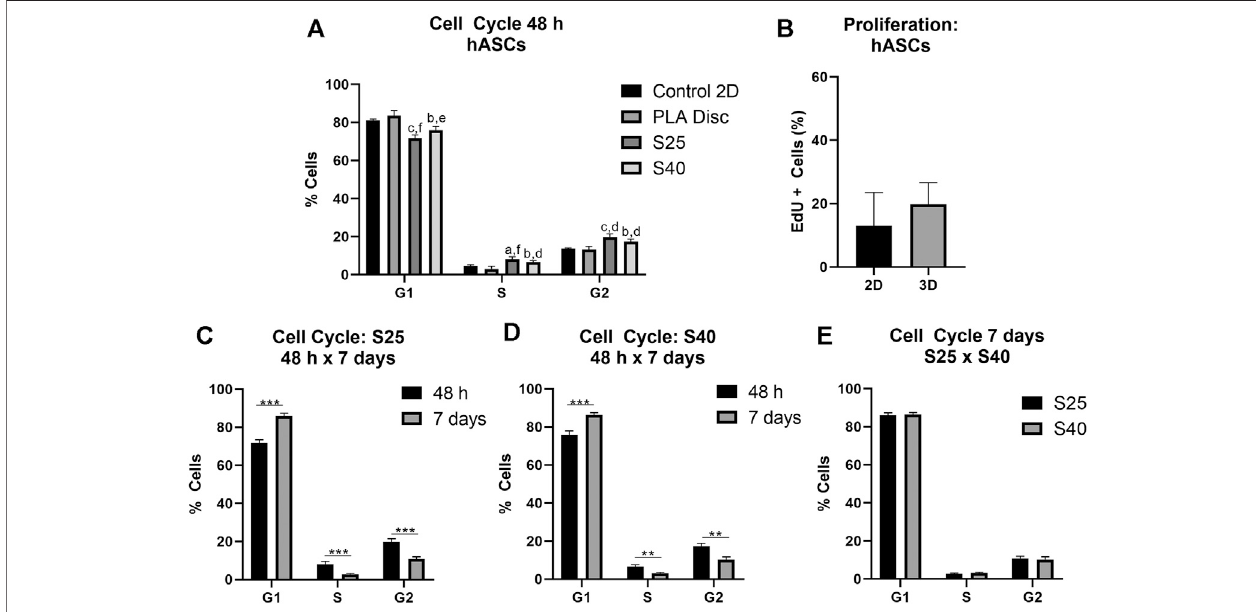
FIGURE 5 | hASCs cell cycle and proliferation after the culture on the PLA scaffolds (A) Percentage of hASCs in each of the phases of the cell cycle after 48 h of cultureonthescaffoldsincomparisontothecultureonthePLAdiscandthecontrol(Control2D n (cid:1) 4;PLAdisc n (cid:1) 3;S25 n (cid:1) 4;S40 n (cid:1) 4).One-wayANOVA: a p ≤ 0.05 incomparisontothecontrol2D; b p ≤ 0.01incomparisontothecontrol2D; c p ≤ 0.001incomparisontothecontrol2D; d p ≤ 0.05incomparisontothePLAdisc; e p ≤ 0.01 incomparisontothePLAdisc; f p ≤ 0.001incomparisontothePLAdisc (B) CellproliferationanalysisbyEdUincorporationafter48 hofcultureonthe3Dscaffoldin comparisontothecontrol(2D)(Control2D n (cid:1) 4;3D n (cid:1) 4) (C) Percentageofcellsineachofthephasesofthecellscycleafter48 hand7 daysofcultureontheS25(S25 7 days n (cid:1) 4) (D) andontheS40(S407 days n (cid:1) 3) (E) Comparisonofthepercentageofcellsineachofthephasesofthecellcycleafter7 daysofcultureontheS25and S40. For the 3D scaffolds n represents the number of groups comprising three scaffolds that was analyzed. Graphs are represented by the mean ± SD. Student ’